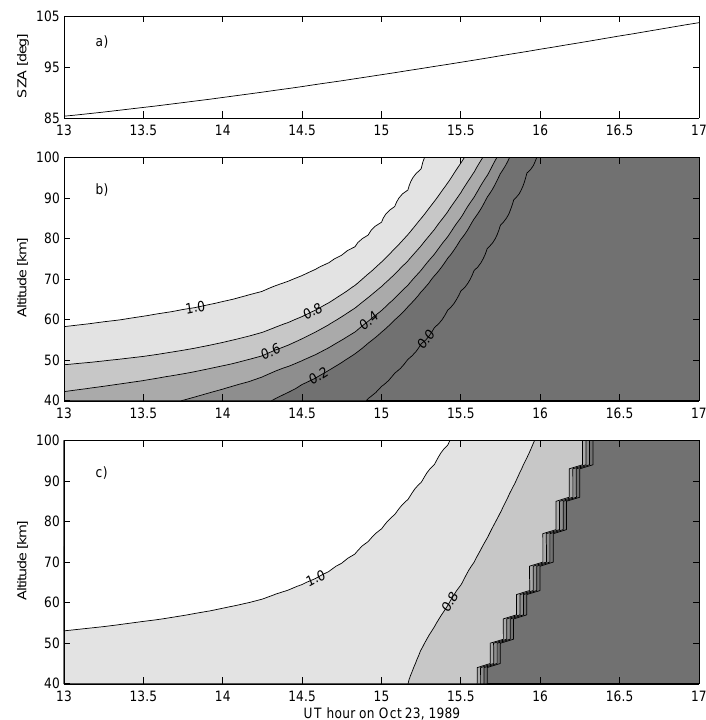
Fig. 2. (a) Solar zenith angles for the sunset of 23 October. (b) Calculated scaling factors for UV-dependent reaction rate coefficients. Fig. 2. a) Solar zenith angles for the sunset of October 23. b) Calculated scaling factors for UV-dependent reaction rate (c) Same as (b) but for VIS-dependent reactions. The same contour lines are shown in both (b) and (c), but for practical reasons only two of coefficients. c) Same as b) but for VIS-dependent reactions. The same contour lines are shown in both b) and c), but the lines are labelled in the bottom for practical reasons only two of the lines are labelled in the bottom panel.